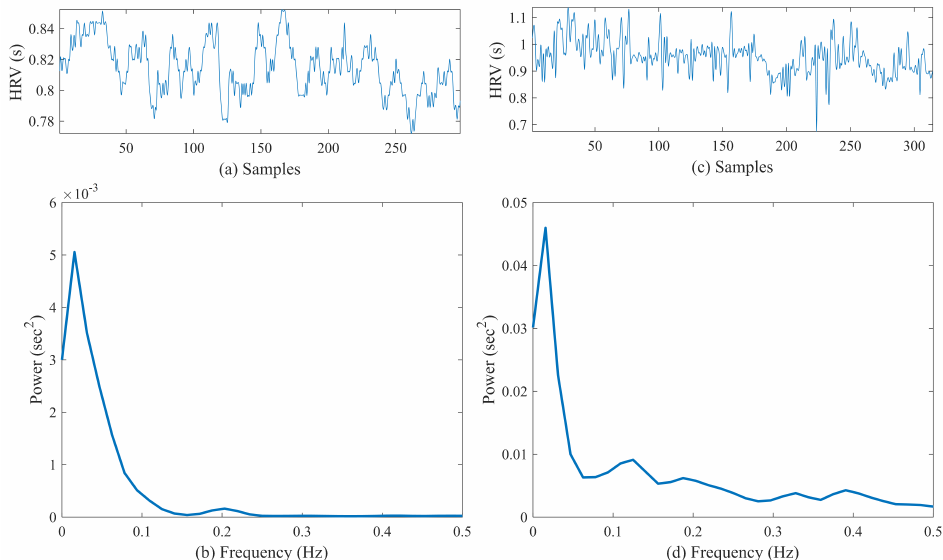
Figure 3. ( a ) Preprocessed heart rate signal from a control subject and ( b ) the corresponding PSD. ( c ) Preprocessed heart rate signal from a pre-AF segment and ( d ) the corresponding